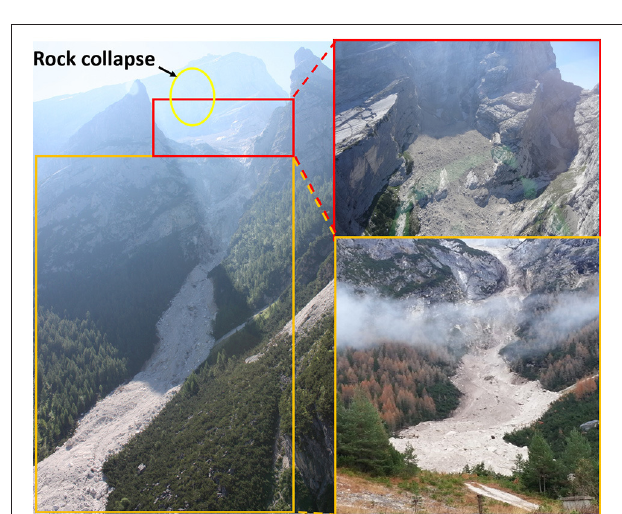
FIGURE 4 | View of the collapsed cliff on the northwestern side of the Mount Antelao (flight of 1 July 2015) and the deposits of debris material from the base of the collapsed cliff to just upstream the confluence with Ru Secco creek. Top right insert shows the debris material covering the Vallon d’Antermoia rocky surface at the base of the collapsed cliff (flight of 1 July 2015). Bottom right insert shows the Ru Salvela creek covered by debris material till the confluence with Ru Secco creek that was obstructed (picture taken on November